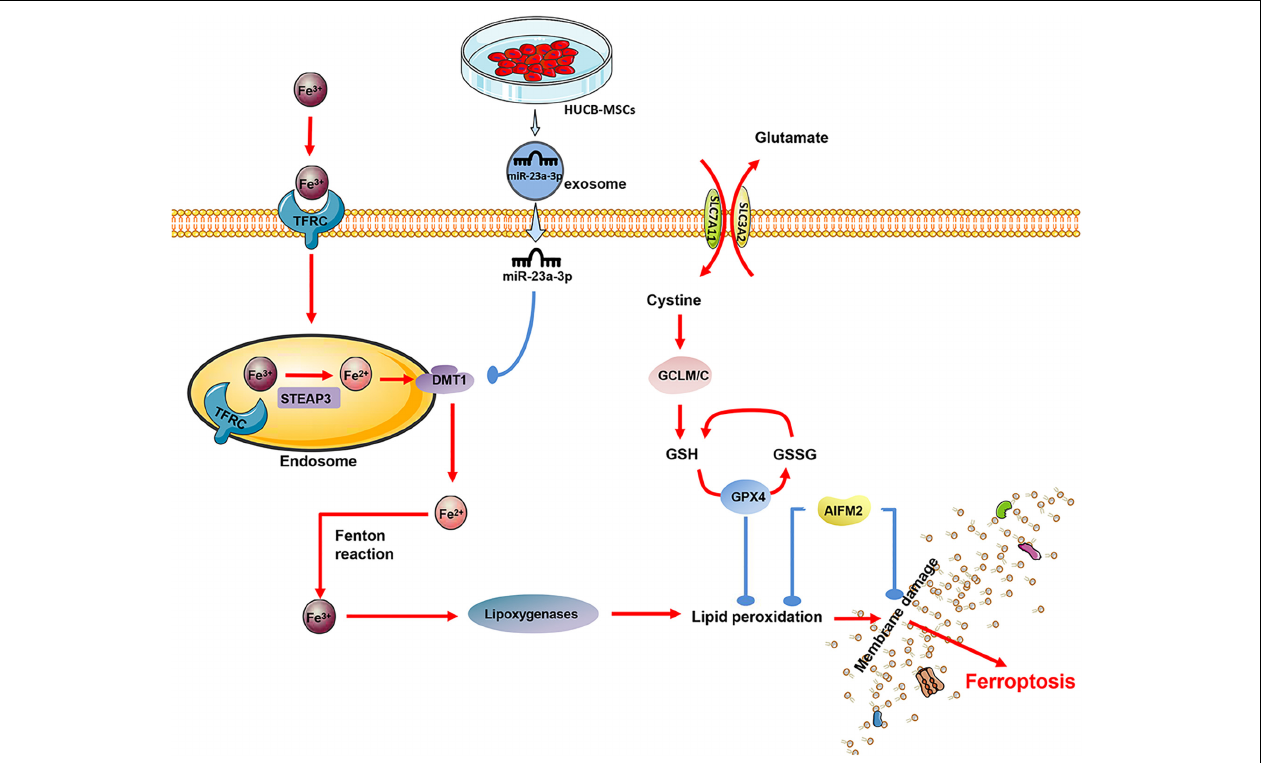
FIGURE 4 | The exosomes derived from human umbilical cord blood (MSCs) contain a significant amount of miR-23a-3p, which inhibits the expression of DMT1 after entering the cardiomyocytes, thereby reducing intracellular lipid oxidation and inhibiting the ferroptosis of cardiomyocytes.